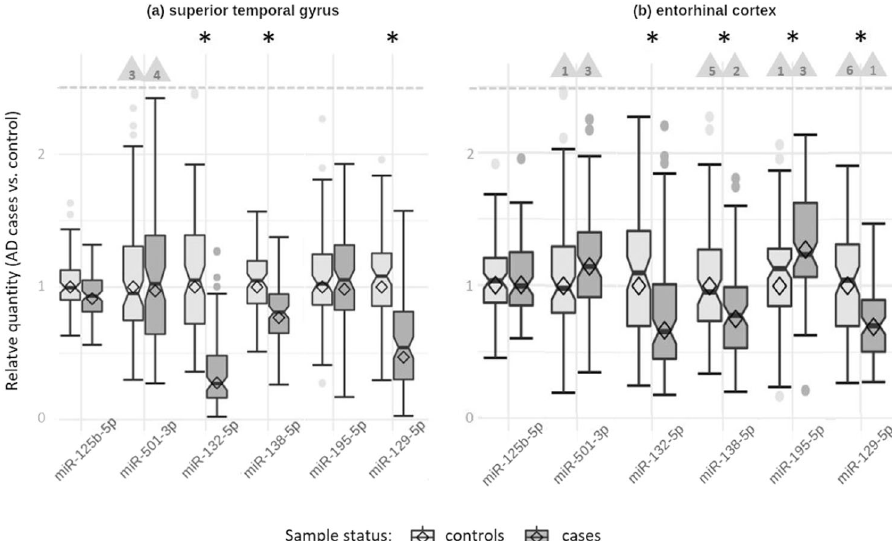
Fig. 1 Expression levels of analyzed miRNAs in Alzheimer ’ s disease patients relative to controls. a Superior temporal gyrus (STG) samples analyzed by qPCR. b Entorhinal cortex (EC) samples analyzed by small RNA sequencing. Bars fi lled in light gray: controls; bars fi lled in dark gray: AD cases; *: statistically signi fi cant difference at α = 0.0167 (see “ Methods ” ). The relative quantity of miRNA expression was calculated using the ΔΔ Ct method; diamonds represent the mean expression (cases relative to controls) based on the ΔΔ Ct method (relative quantity = 2 ( − (dCt cases - dCt controls)) ). Horizontal lines represent median values of the corresponding sample-speci fi c values (individual dCt values normalized to the mean of the control samples), boxes represent interquartile ranges, and whiskers extend to the minimum and maximum observed value within 1.5x the interquartile range; values outside this range but below the dashed line are depicted as dots. The box notches indicate the 95 % con fi dence intervals. Outliers exceeding the dashed line are not shown (for scaling purposes) but counted and indicated by the numbers in the